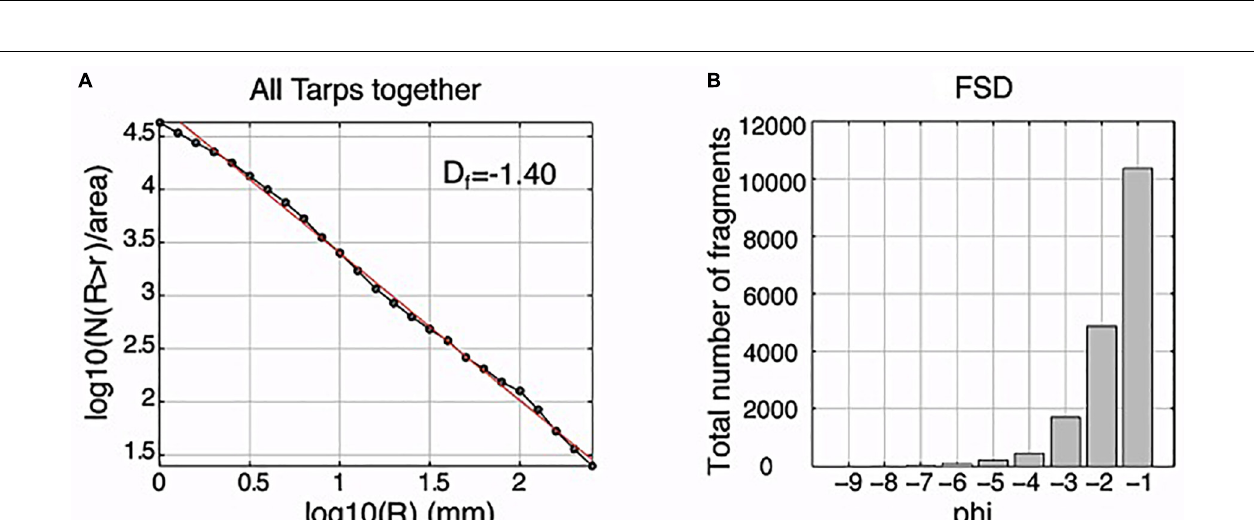
Frontiers in Earth Science |